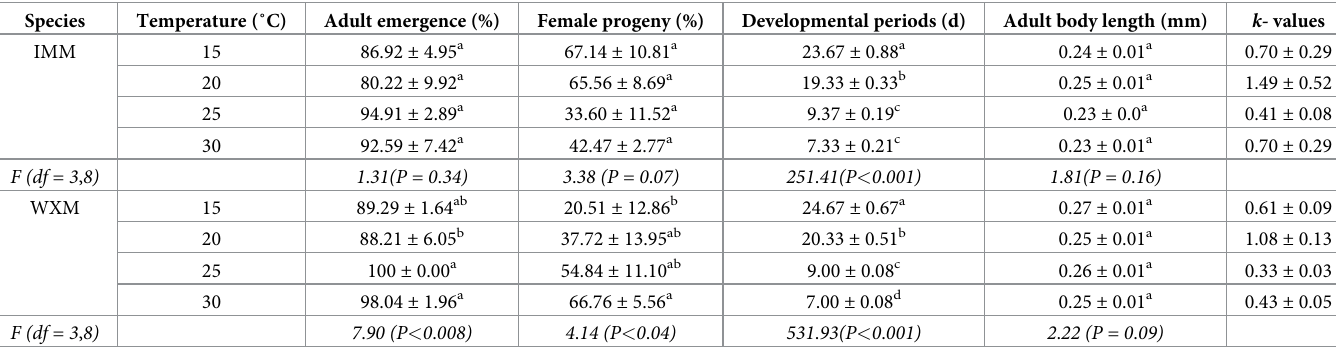
Table 3. Effect of temperature (mean ± SE) on the biological traits of T . evanescens reared on eggs of P . interpunctella (IMM) and G . mellonella (WXM). Species Temperature (˚C) Adult emergence